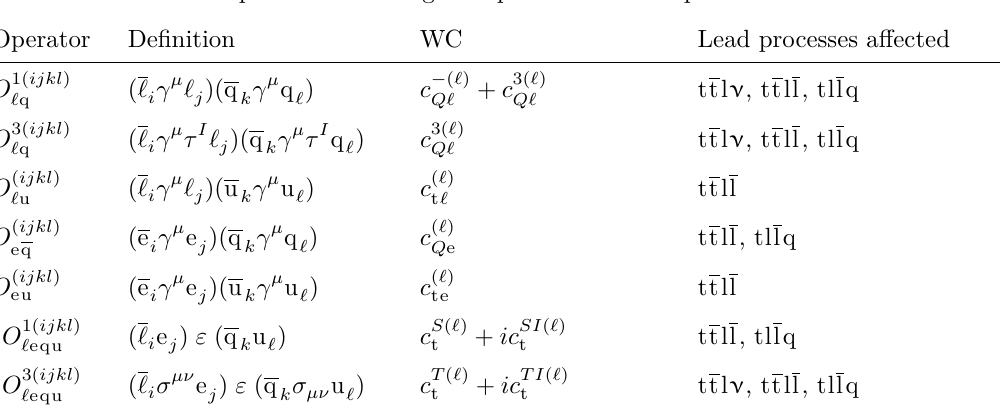
field strength. The abbreviations s and c denote the sine and cosine of the weak mixing angle W W (in the unitary gauge), respectively. The leading processes affected by the operators are also listed (the details of the criteria used for this determination are described in the